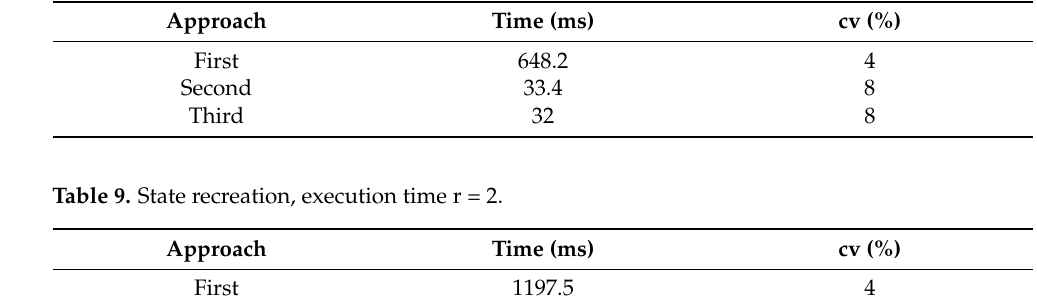
Figure 15. Obtaining the state of a network model (approach 3). Table 8. State recreation, execution time r = 1.